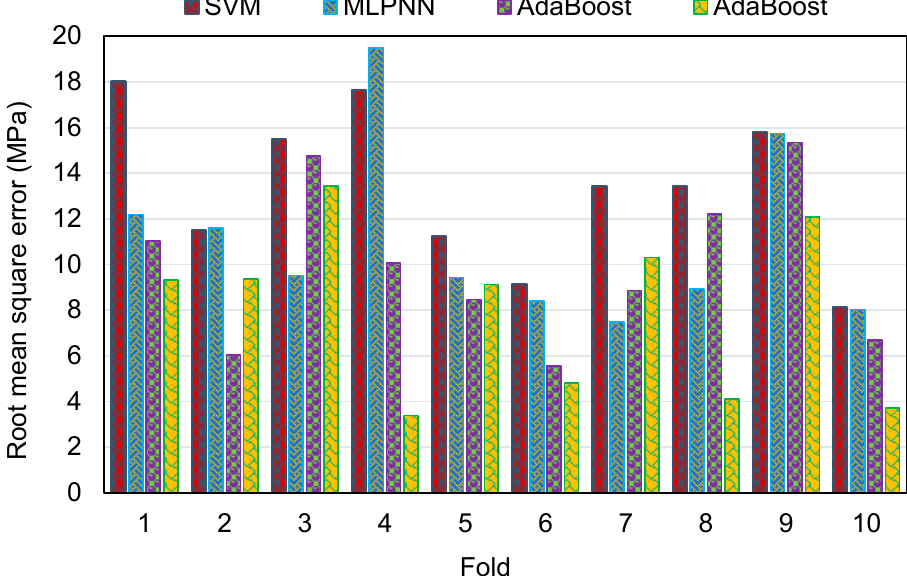
Figure 17. Comparison of root mean square error for all models from the k-fold analysis.